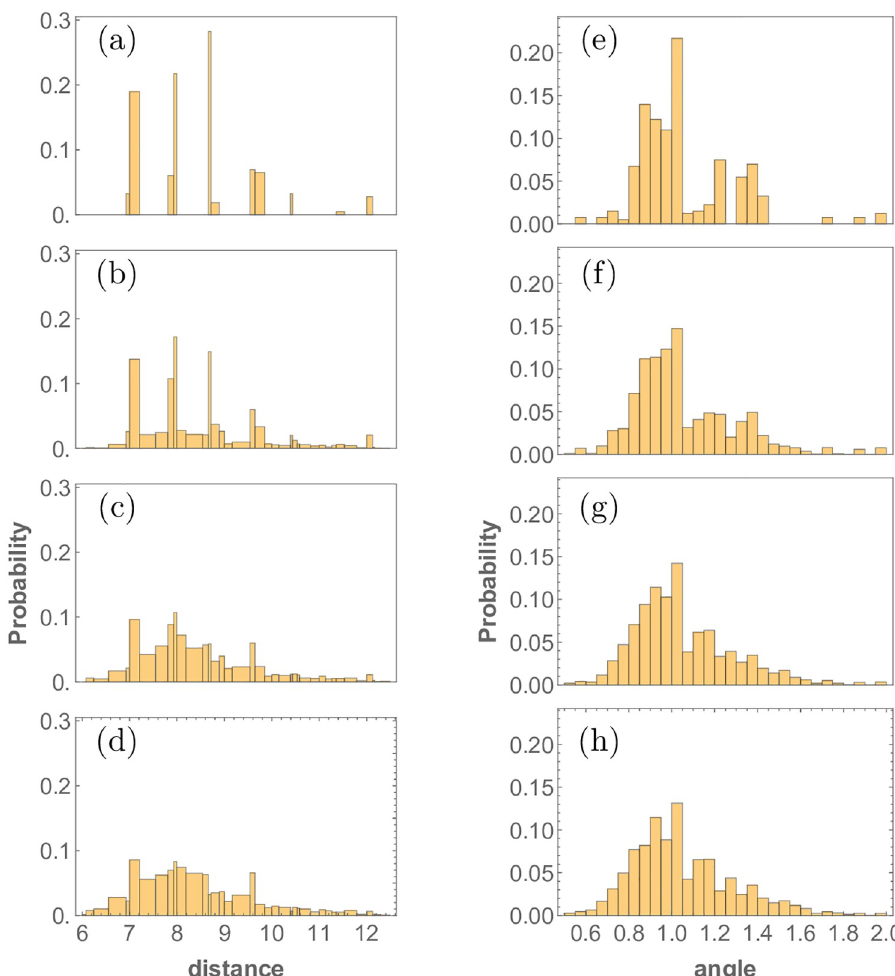
Fig 7. Nearest neighbor distance (left panels) and angle (right panels) probability distributions generated from the point-pattern in the Drosophila eye disc R8 cell specification for increasing noise levels. Stochasticity was introduced in the differential equations by drawing the value of the diffusion coefficients D distribution with mean μ and standard deviation σ . The nearest neighbor distance histograms in (a) to (d) and nearest neighbor angle histograms in (e) to (h) correspond Gaussian stochasticity with standard deviations σ / μ = 0%, 30%, 40%, 60%. While the first two histograms are almost identical, as noise in the diffusivity of the morphogens increases, the peaks get smeared out and the histograms appear